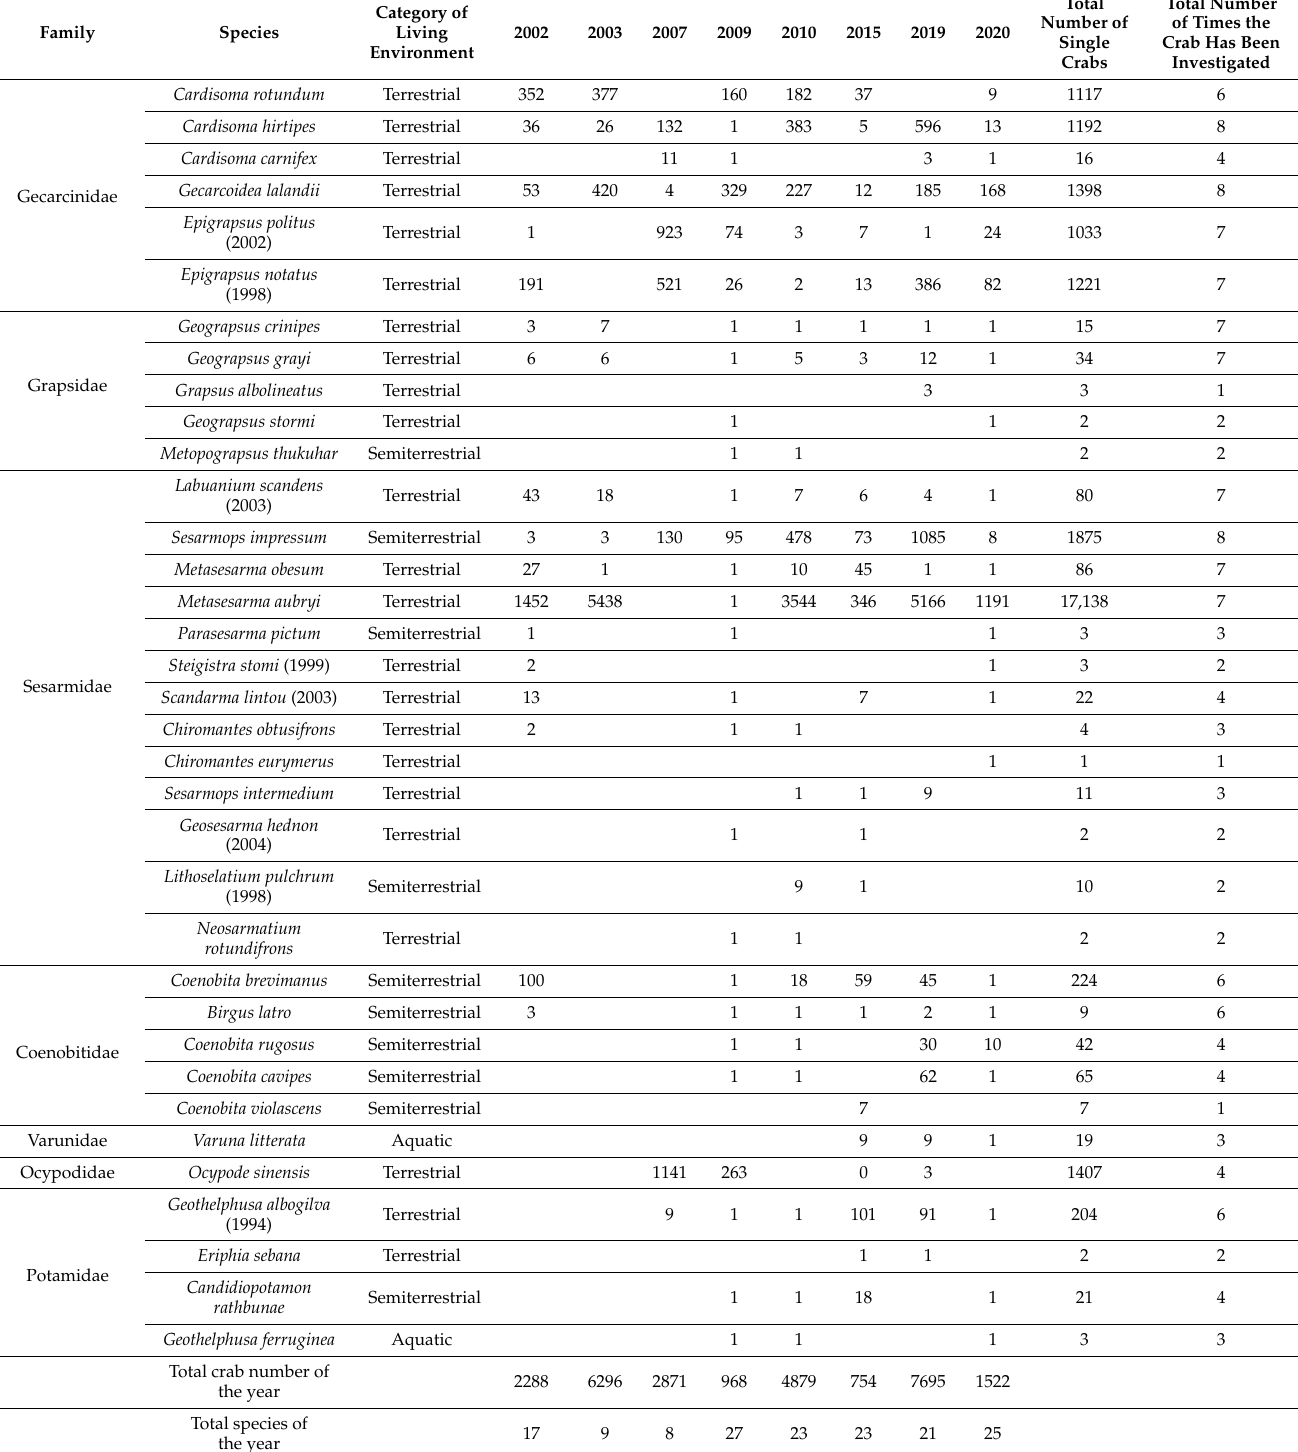
Table 1. Land crab species investigated in the study area and their number of records